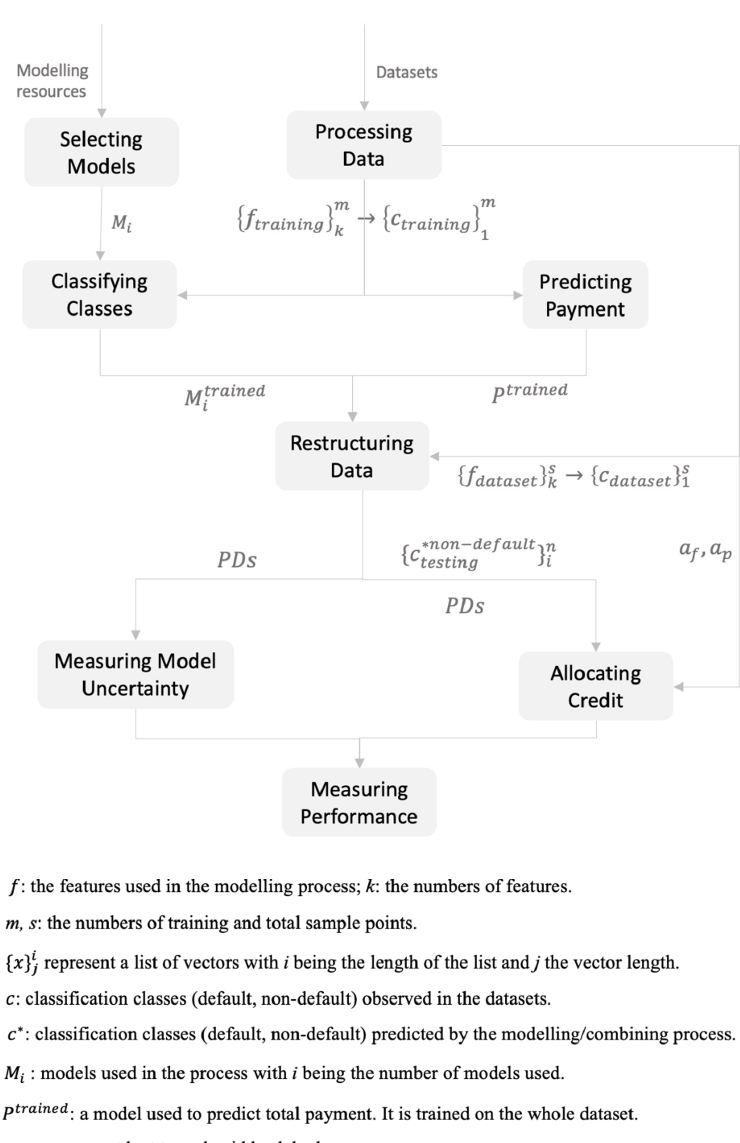
Figure A1. Optimal credit allocation process.